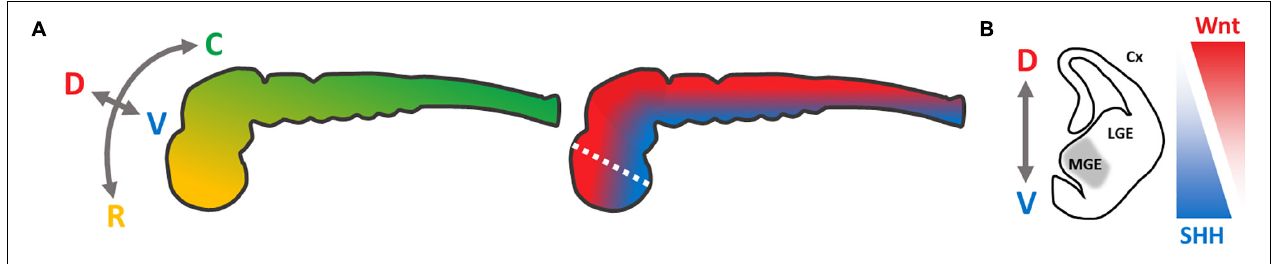
FIGURE 1 | Schematic presentation of neural axes during neurogenesis of the central nervous system, modified from Petros et al. (2011). (A) Color-coded visualization of the rostro-caudal (yellow–green) and dorso-ventral (red–blue) axes of the neural tube; C, caudal; D, dorsal; R, rostral; V, ventral. (B) Coronal section of the left hemisphere (white dotted line in A ) of the telencephalon, to visualize the targeted regional identity of the medial ganglionic eminence (gray). SHH-/Wnt-pathway activity is indicated in triangles. Cx, cortex; LGE, lateral ganglionic eminence; MGE, medial ganglionic eminence.